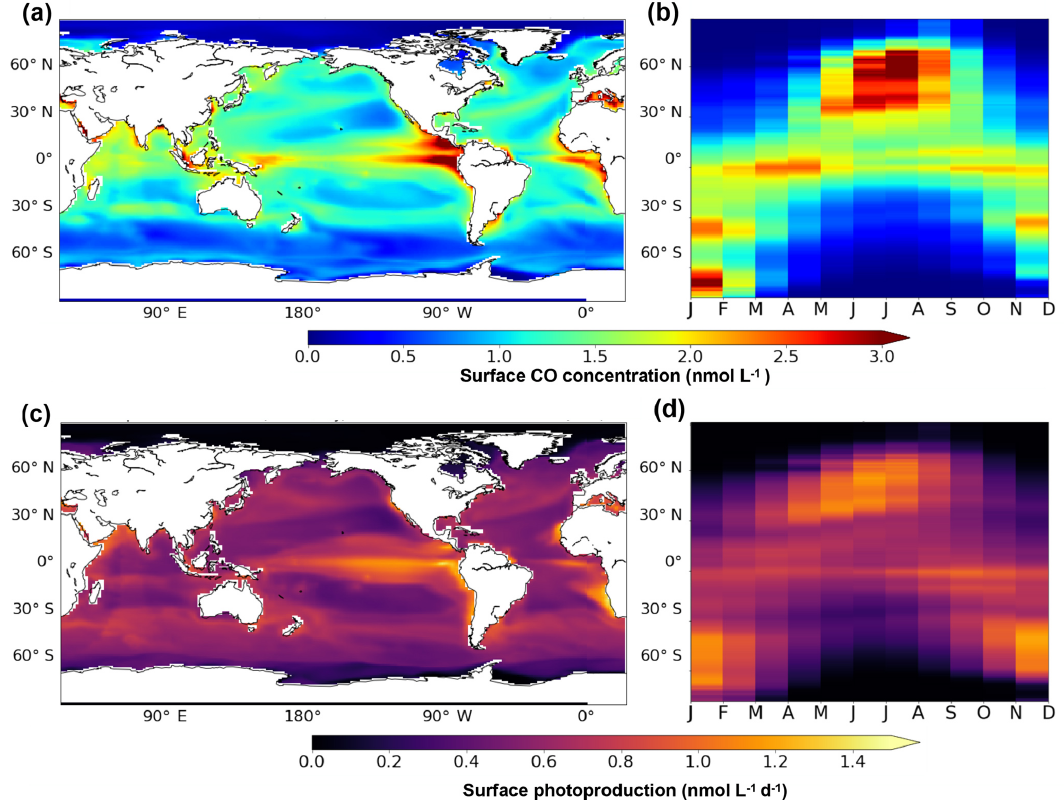
Figure 5. Oceanic CO concentration (a, b) and photoproduction (c, d) between 0 and 10m. Panels (a) and (c) present the surface spatial distribution of the annual mean. Panels (b) and (d) present the mean seasonal variation with